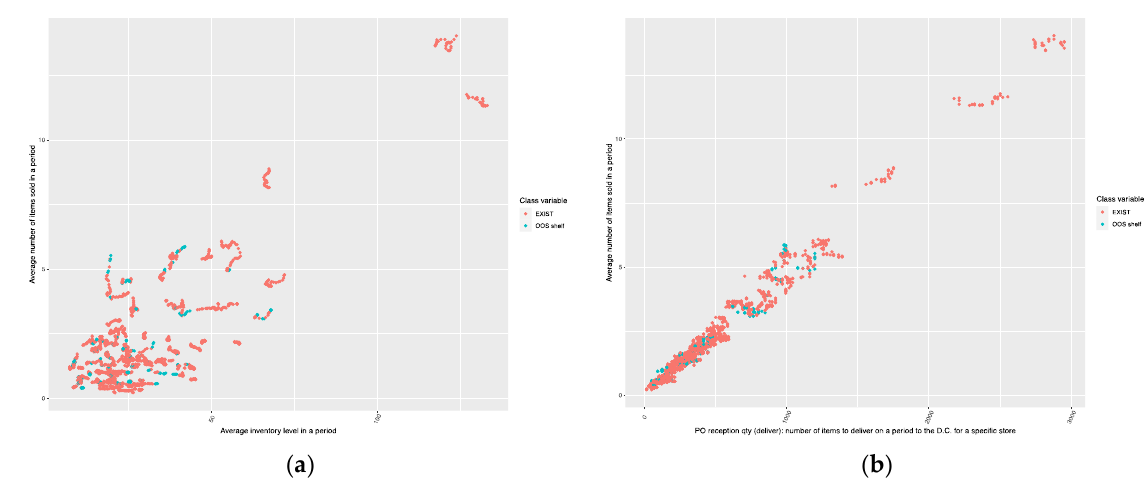
Figure 5. Exploratory Data Analysis (EDA) on DS.CS_2 Dataset. Relationship between predictor variables and class variable: ( a ) Average inventory level in a period vs. Average number of items sold in a period; ( b ) PO reception qty (deliver): number of items to deliver in a period to D.C. for a specific store.